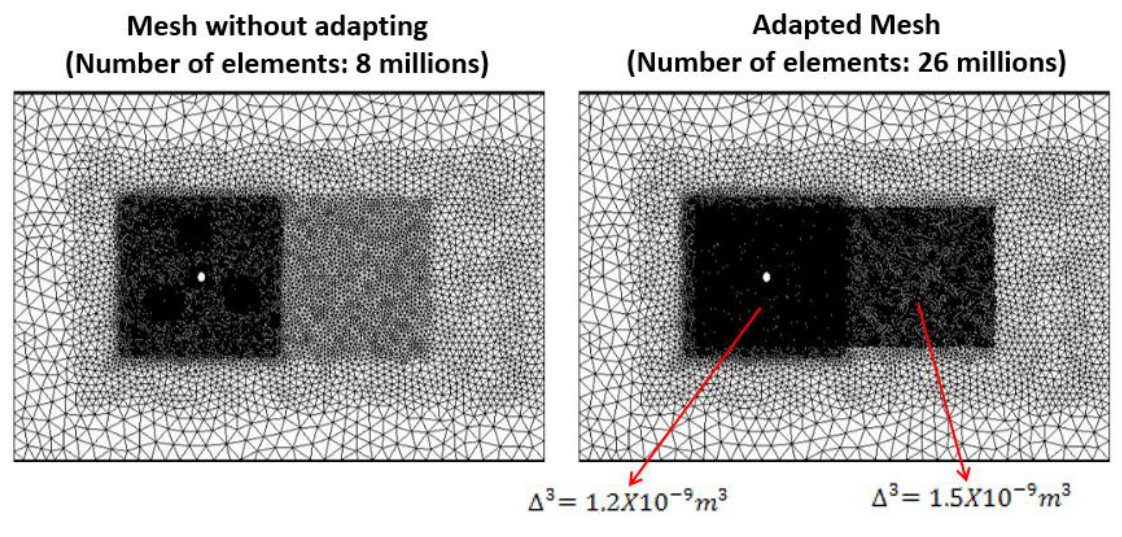
( b ) Figure 6. ( a ) ROI in the instantaneous vorticity field on the symmetry plane for the URANS model, ( b ) Vortex capture by image processing in regions of interest in a vorticity contour. The objective of the algorithm is to filter the vortices shed by the blades in two ways, according to the intensity of the vorticity field in a plane and a geometric threshold. The threshold allows to identify vortices with a roughly circular or spiral pattern [17]. When the threshold is equal to 1 the algorithm identifies a vortex with a circular shape and as it decreases, vortices with spiral shape begin to be identified. The measurement of the diameter of the vortices was performed in five planes along the span of the turbine, looking for the smallest vortex in the wake of the blades and the turbine. With the LES filter value of ∆ = 0.00106 m, the volume of refinement of the cells (∆ 3 = 1.2 × 10 −9 m 3 ) was estimated. Taking into account the computational cost of the simulations and to ensure a smooth transition between elements of the rotating domain and those of the wake of the turbine, a cell volume size of ∆ 3 = 1.5 × 10 −9 m 3 was used in the far field. The adaptation of the DES mesh was made with these two volumes of refinement. The total number of elements of the adapted mesh was 26 million as shown in Figure 7.